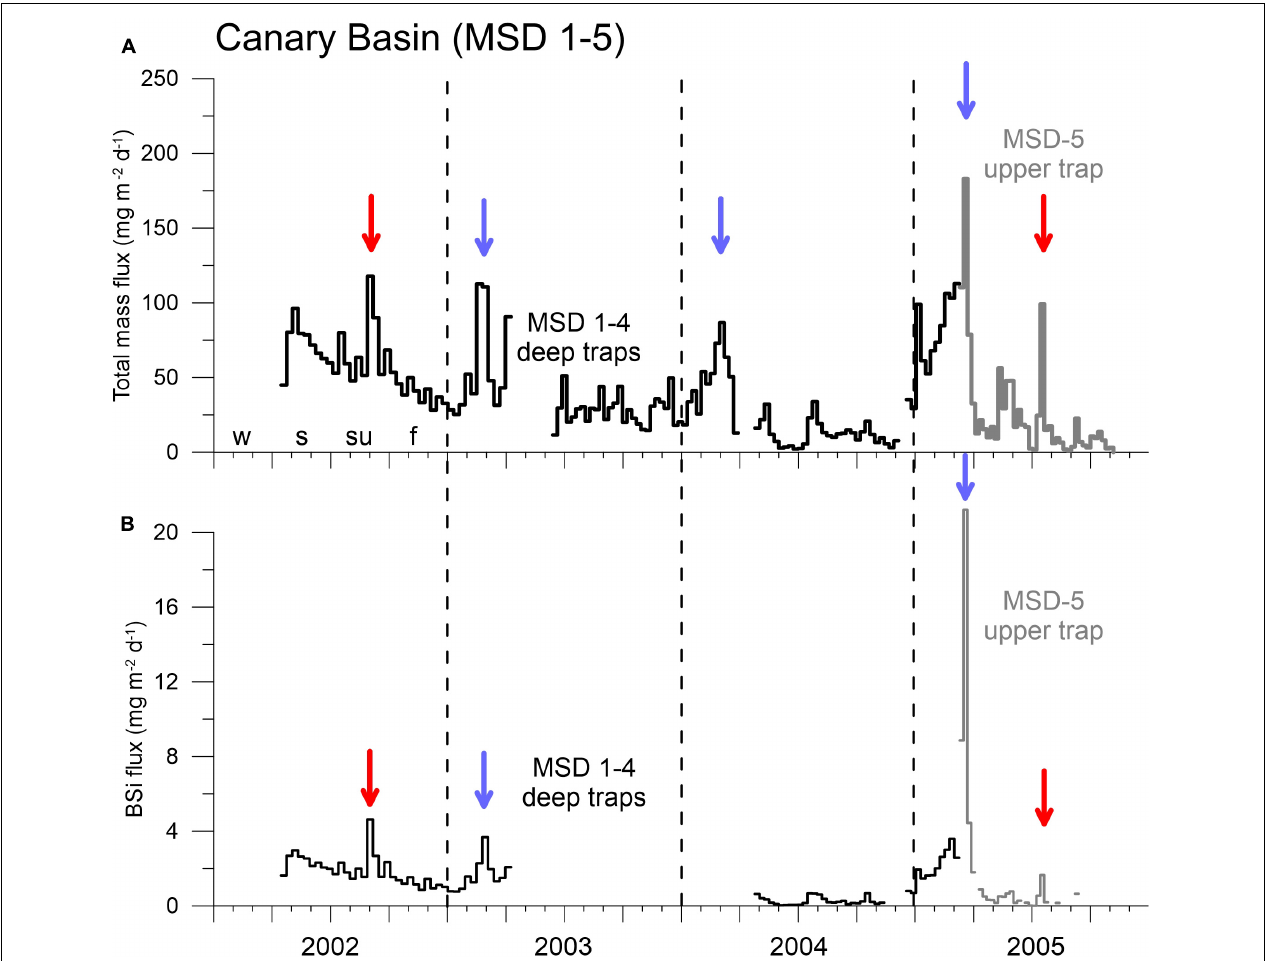
FIGURE 6 | High resolution total mass ( A , mg m − 2 d − 1 ) and BSi flux ( B , mg m − 2 d − 1 ) record at the MSD site (MSD1–4 lower traps, MSD-5 upper trap, Supplementary Material ) between 2002 and 2005, revealing regular winter peaks in February-March (blue arrows) and unusual high fluxes in winter 2005. Red arrows mark high summer fluxes. Vertical hatched lines indicate the years (with the four seasons winter = w, spring = s, summer = su, fall = f; starting on Jan.